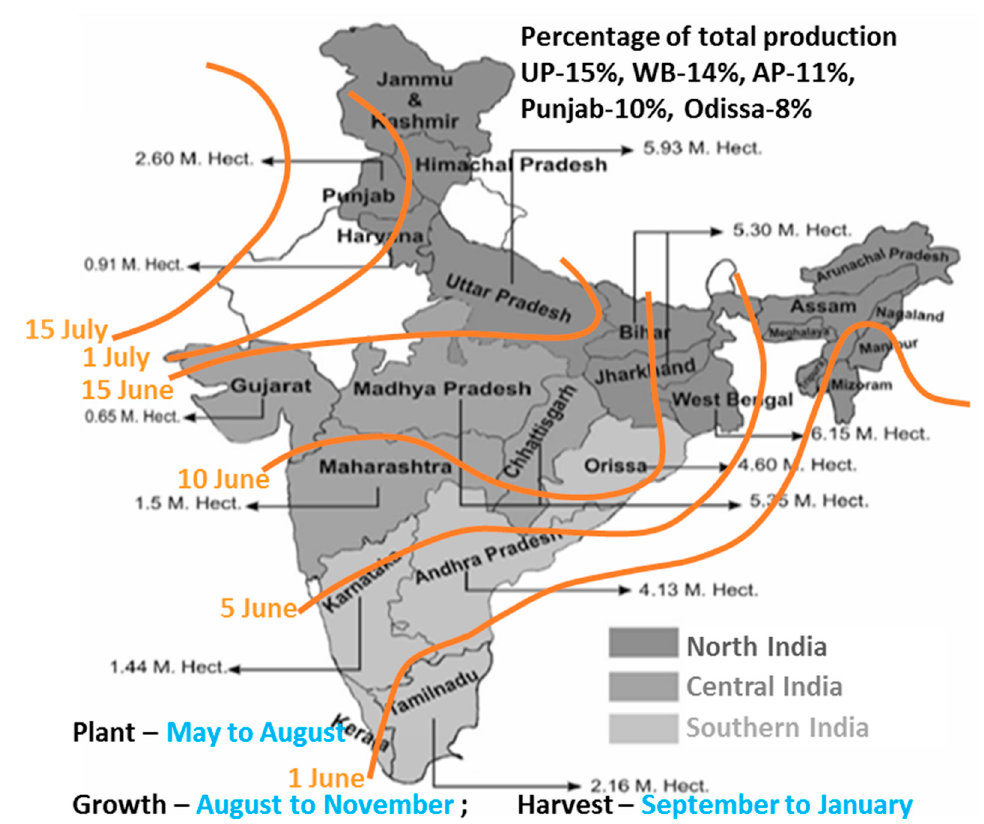
Figure 9. The date and line of the northern limit of the summer monsoon (climatological rainfall isochrones, orange lines) and area of land under rice crop production in each state (modified after [48]).